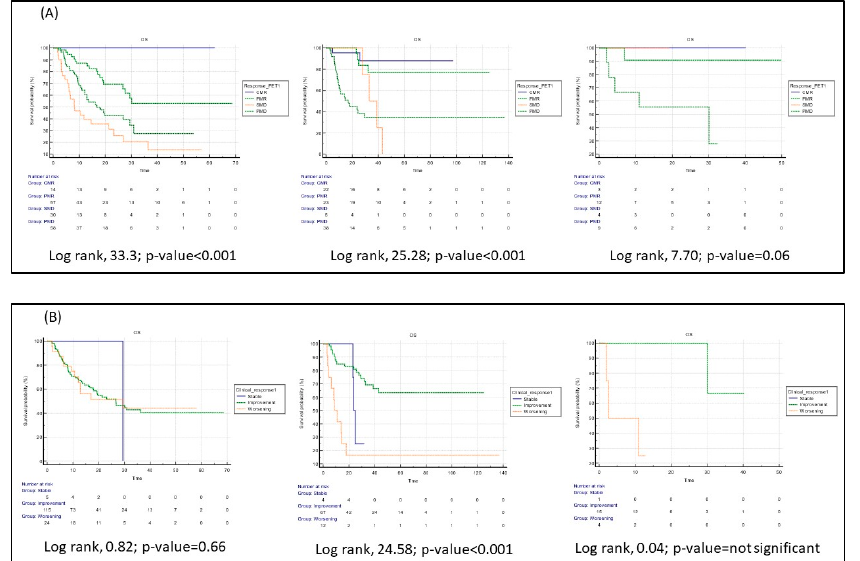
Figure 3. Kaplan–Meier curves for OS based on the first PET/CT scan ( A ) and clinical examination ( B ), by type of cancer ( n = 159 patients with lung cancer, n = 89 patients with malignant melanoma and n = 28 patients with other tumors). CMR = complete metabolic response; PMR = partial metabolic response; SMD = stable metabolic disease; PMD = progressive metabolic disease; Time was expressed in months.